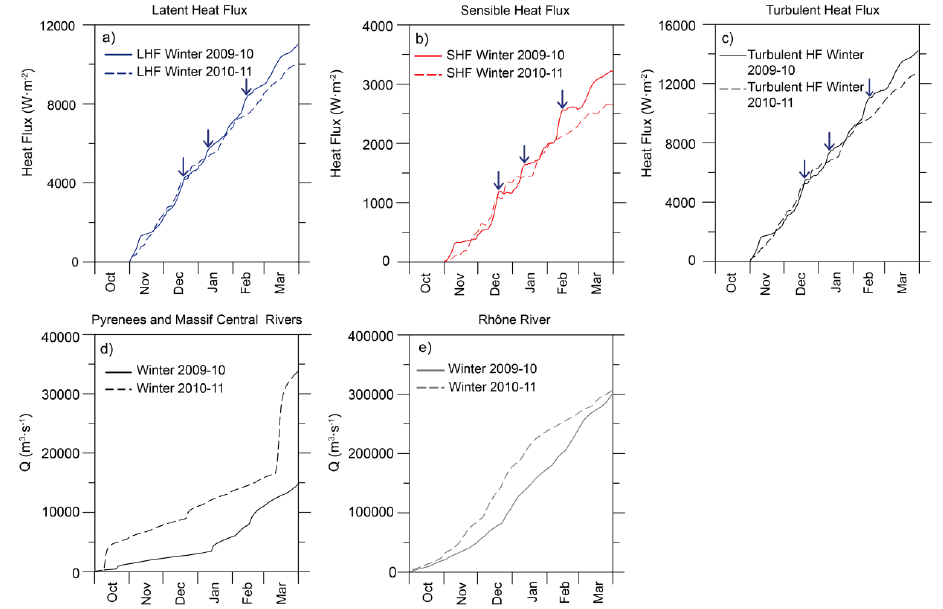
Fig. 3. (a) Cumulated Latent Heat Flux for winter-spring 2009–2010 (continuous line) and 2010–2011 (dashed line); (b) Cumulated Sensible Heat Flux for winter-spring 2009–2010 (continuous line) and 2010–2011 (dashed line); (c) Cumulated Turbulent Heat Flux for winter-spring 2009–2010 (continuous line) and 2010–2011 (dashed line); (d) Cumulated river discharge from the H´erault, Orb, Agly, Aude, Tech and Tˆet rivers for winters 2009–2010 (continuous line) and 2010–2011 (dashed line); (e) Cumulated river discharge from the Rhˆone river for winters 2009–2010 (continuous line) and 2010–2011 (dashed line). Blue arrows show period of intense heat losses (as in Figs. 2 and